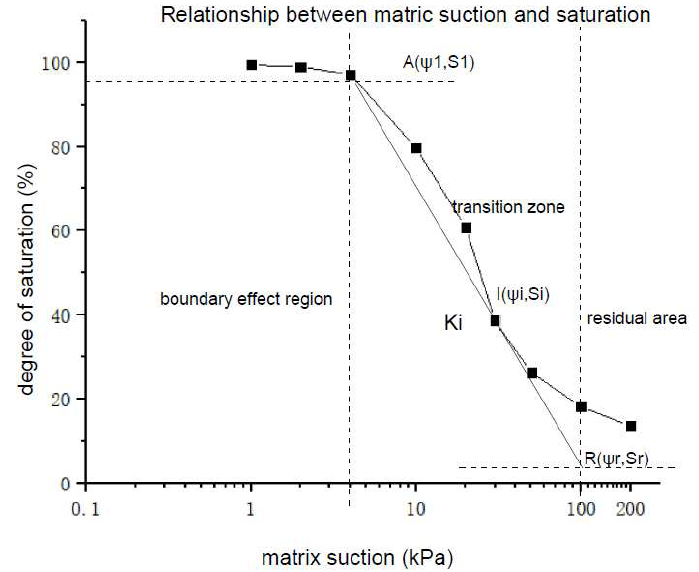
Figure 4. FDJ-20 unsaturated direct shear instrument.